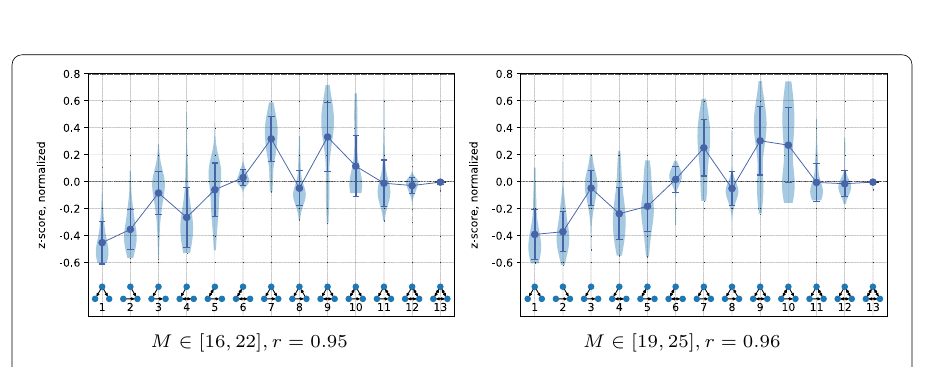
Fig. 6 Motif patterns of robust networks in c , r optimization with N = 20 . Similarly to Fig. 5 we take 50 networks with high r from the Pareto